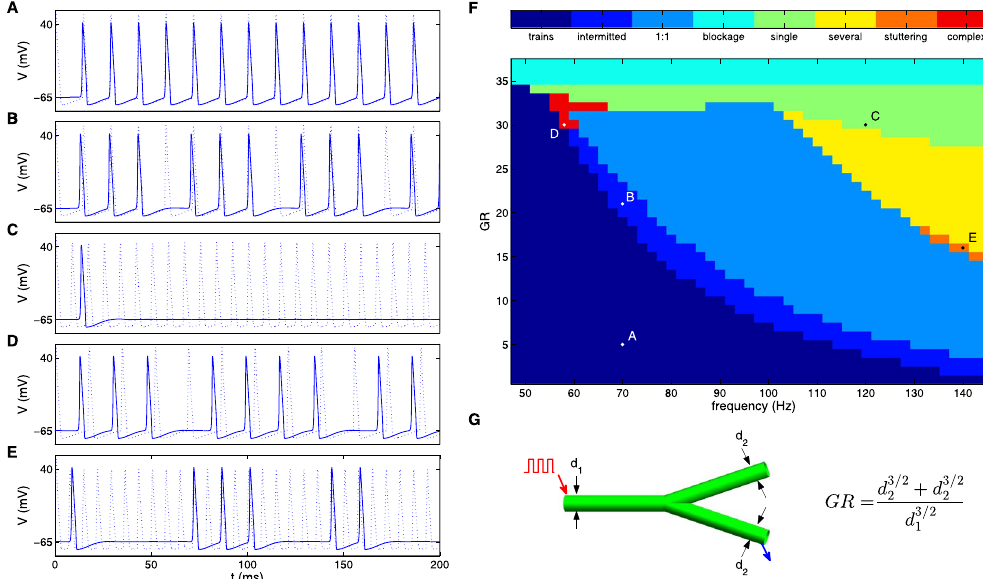
Figure 4. Responses to current stimuli in the studied phase space for branched axons. ( A – E ) time dynamics of propagating signals generated with parameters indicated in phase plane diagram ( F ), the dashed line indicates the response at the stimulation point near the beginning of the mother branch. The colors in the phase plane diagram represent different firing patterns as shown in the color key. The axonal radius of the mother branch used to construct the phase plane is 10 µ m, each segment is 2 cm, and the signals were measured as schematically shown in ( G ) by a blue